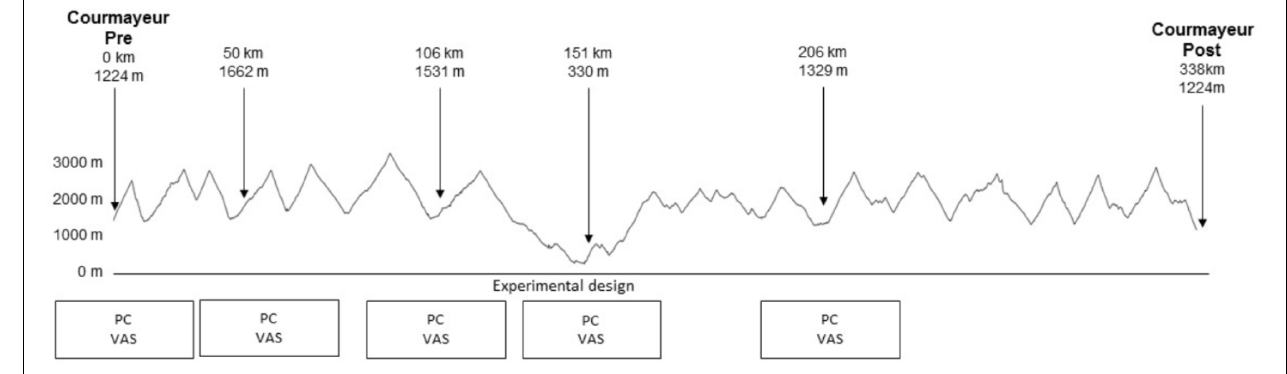
FIGURE 1 | GPS profile of the total race with the test locations and the experimental design (PC: postural control, VAS: visual analog scale).